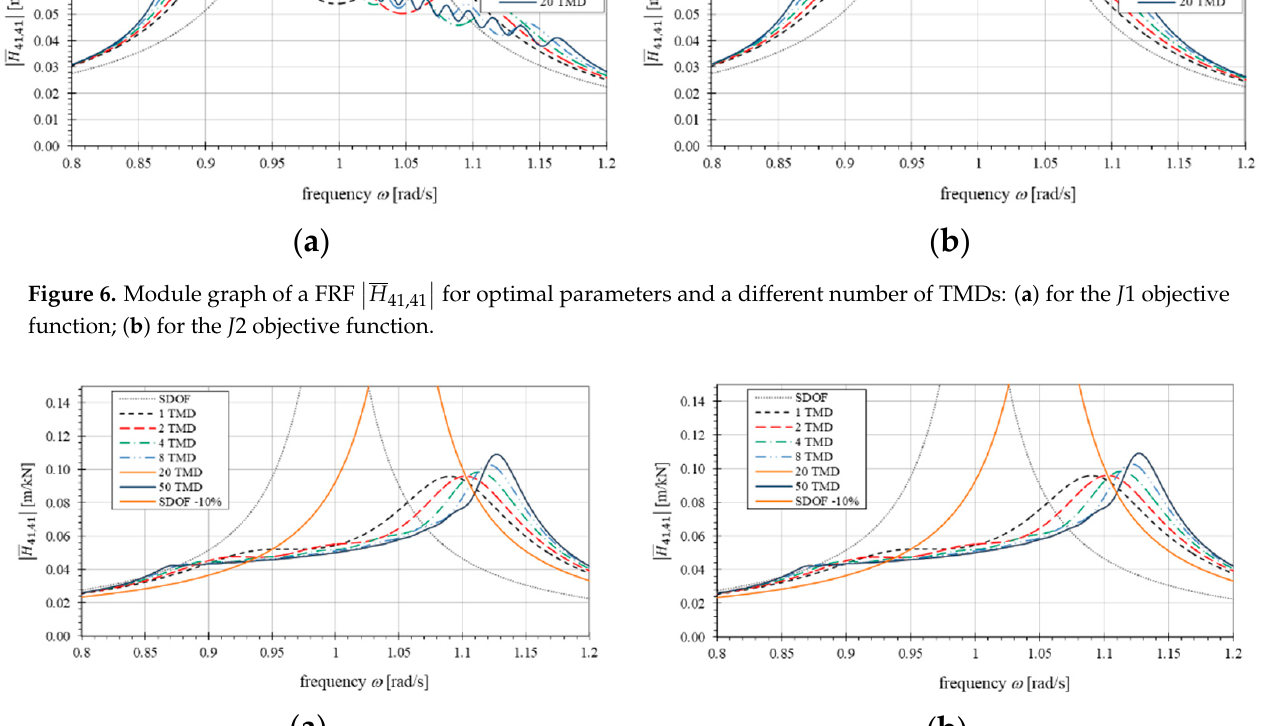
Appl. Sci. 2021 , 11 , x FOR PEER REVIEW 18 of 31 Figure 7. Module graph of a FRF (cid:12) H 41,41 (cid:12) with the mass of the primary system reduced by 10% for optimal parameters and a different number of TMDs: ( a ) for the J 1 objective function; ( b ) for the J 2 objective function.